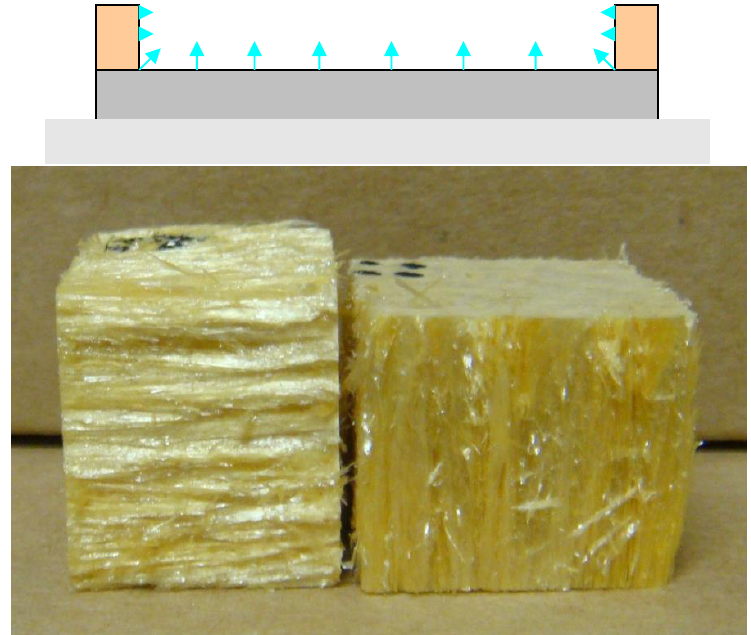
Figure 11. Mold and aerogel monoliths from anisotropic freezing. Table 1. Anisotropic PAI aerogel compressive moduli.